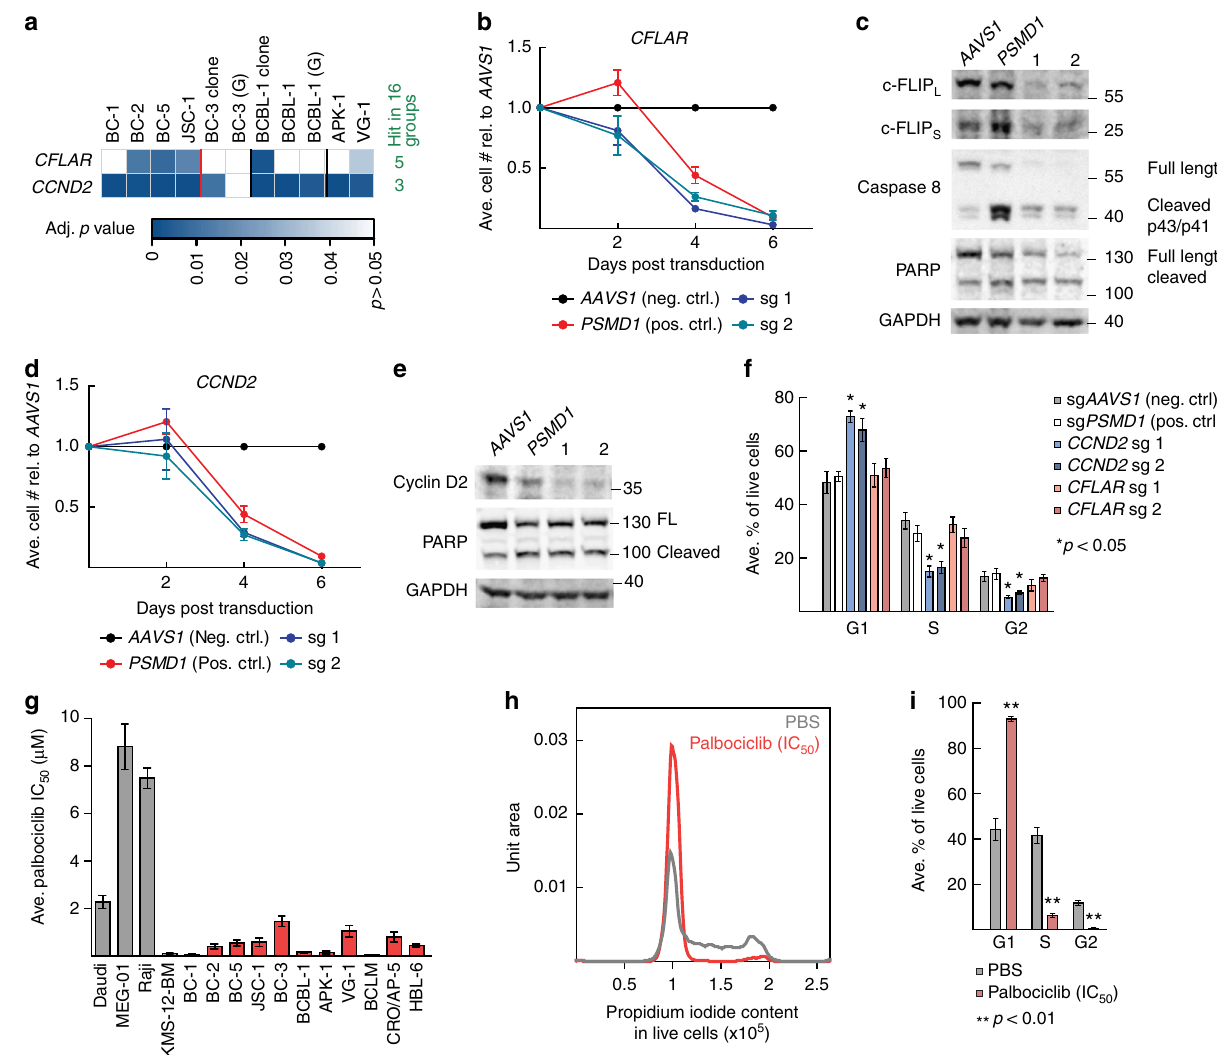
Fig. 4 PEL cell lines are dependent on CCND2 and CFLAR . a Heatmap of adj. p values of sgRNA depletion of CCND2 and CFLAR in cell lines screened. Indicated on the right are the numbers of cancer types (out of 16) where the gene was found to be a potential dependency. The Brunello library was used for most of the screens except where indicated: G, GeCKO v2. b , c Knockout of CFLAR . b Representative analysis of relative live BCBL-1 cell numbers over time following CFLAR knockout. n = 4. c Representative western blots of c-FLIP L and c-FLIP S isoforms for b . d , e Similar to b and c but using CCND2 sgRNAs. Experiments in b – e were performed together and thus share controls. f Distribution of cell cycle phase populations in BCBL-1 Cas9 cells upon CCND2 or CFLAR knockout analyzed by propidium iodide staining of samples on day 4 in experiments shown in b – e . p Values were calculated by Student ’ s t test and compared to sgAAVS1. g Calculated IC 50 values of palbociclib in the indicated cell lines. Gray bars, non-PEL cells; pink bars, PEL cell lines; n ≥ 3. h , i Cell cycle analysis of propidium iodide-stained live BCBL-1 cells treated for 24 h with 220 nM palbociclib (IC 50 ). h Representative histograms of DNA content from propidium iodide staining. i Distribution of cell cycle phase populations. p Values were calculated by Student ’ s t test and compared to PBS-treated cells. n = 3. All error bars,